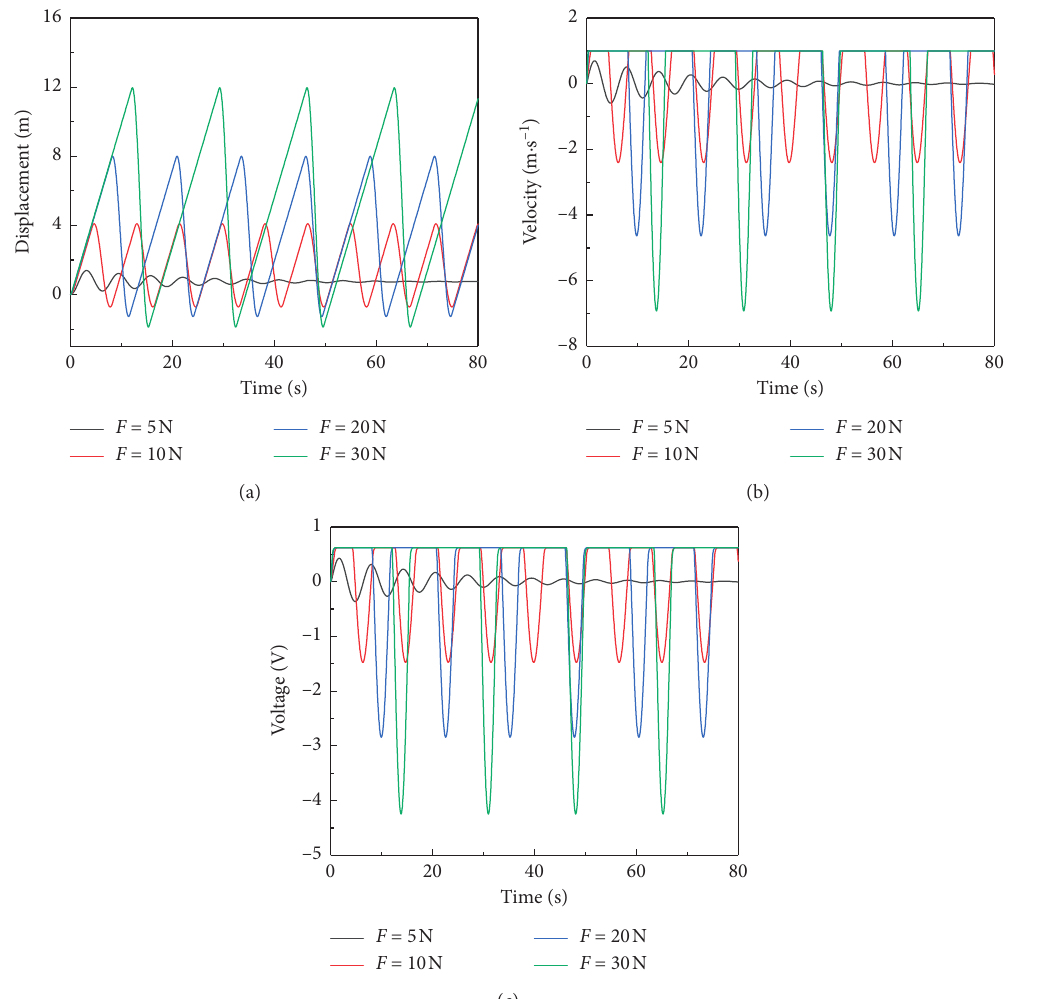
Figure 3: Vibration displacement (a), velocity (b), and output voltage (c) of the friction system with different normal loads in the friction law